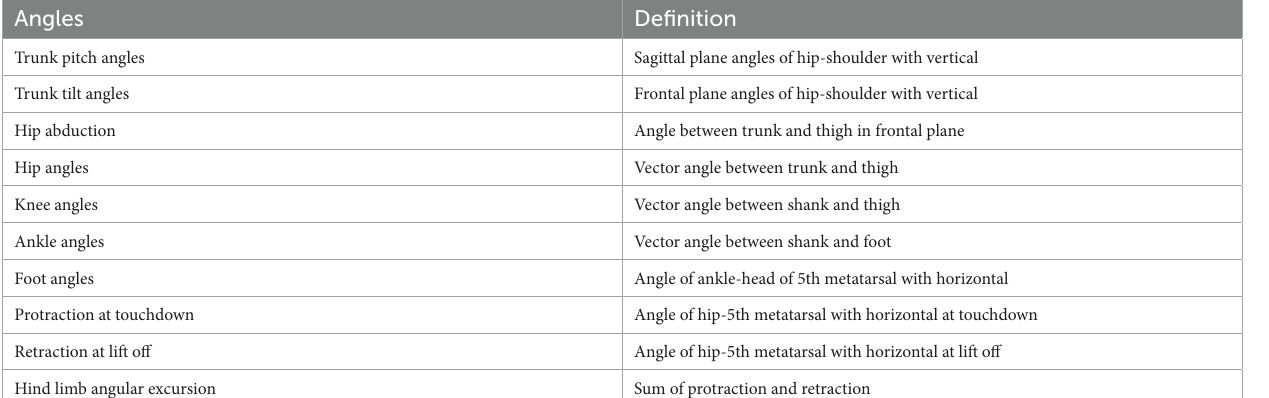
TABLE 3 Joint angles measured in Demes (2011).